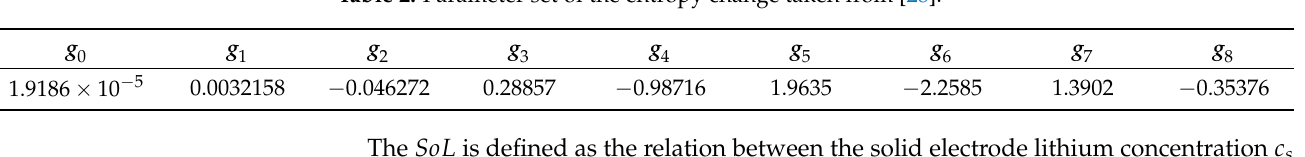
Table 2. Parameter set of the entropy change taken from